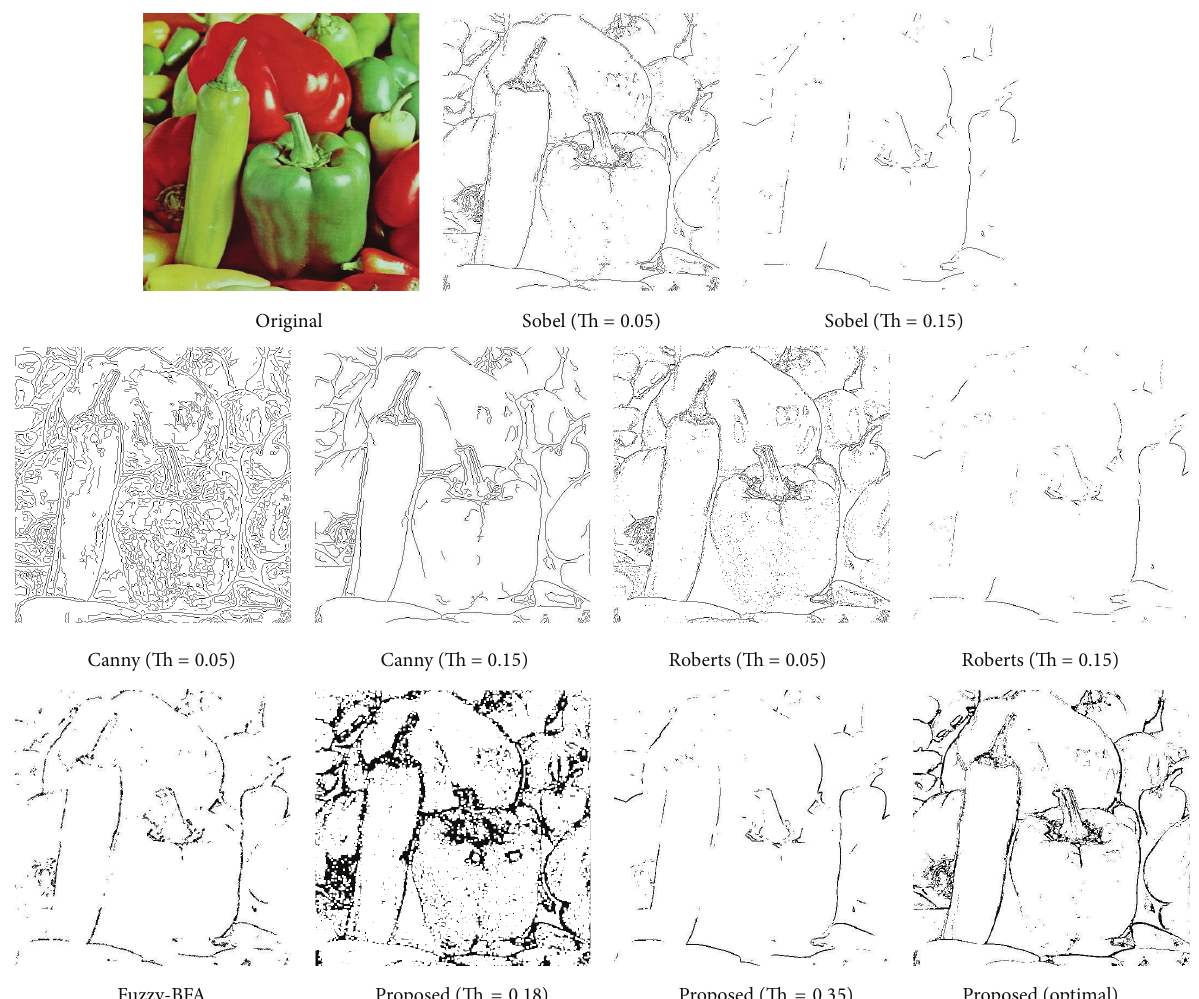
Figure 10: Edge detection results of “peppers” image: Sobel, Canny’s, and Roberts methods using thresholds = 0.05 and 0.15; fuzzy-BFA method; proposed method with fixed thresholds (0.18 and 0.35) and optimal